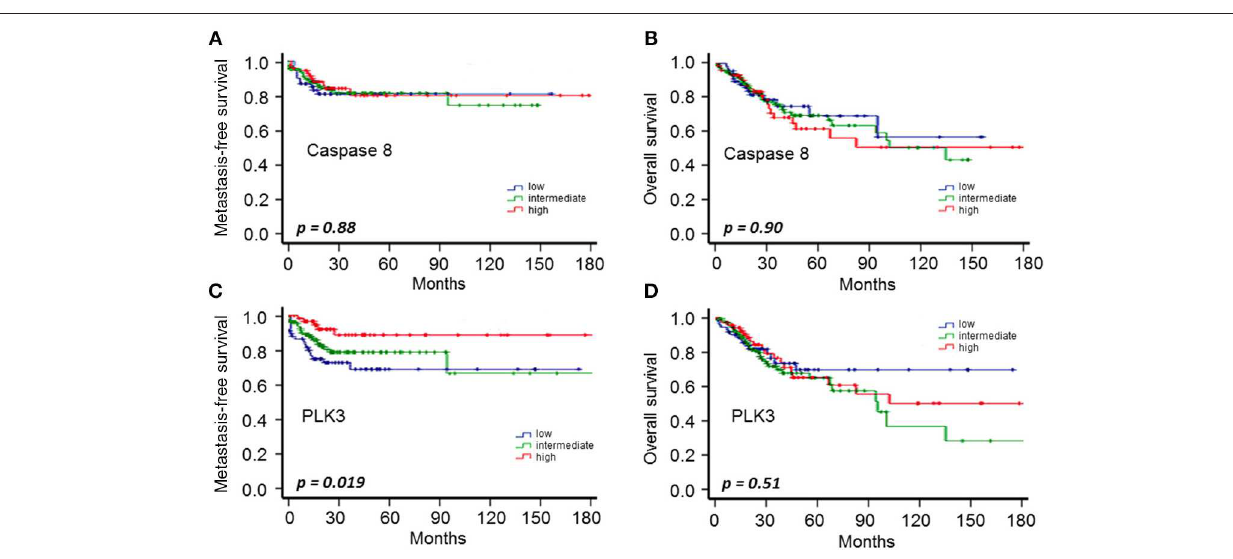
FIGURE 4 | CESC-TCGA data on metastasis-free survival (A,C) and OS (B,D) according to PLK3 and Caspase 8 gene expression (low: 1st quartile; intermediate: 2nd and 3rd quartiles; high: 4th quartile) in CESC patients from